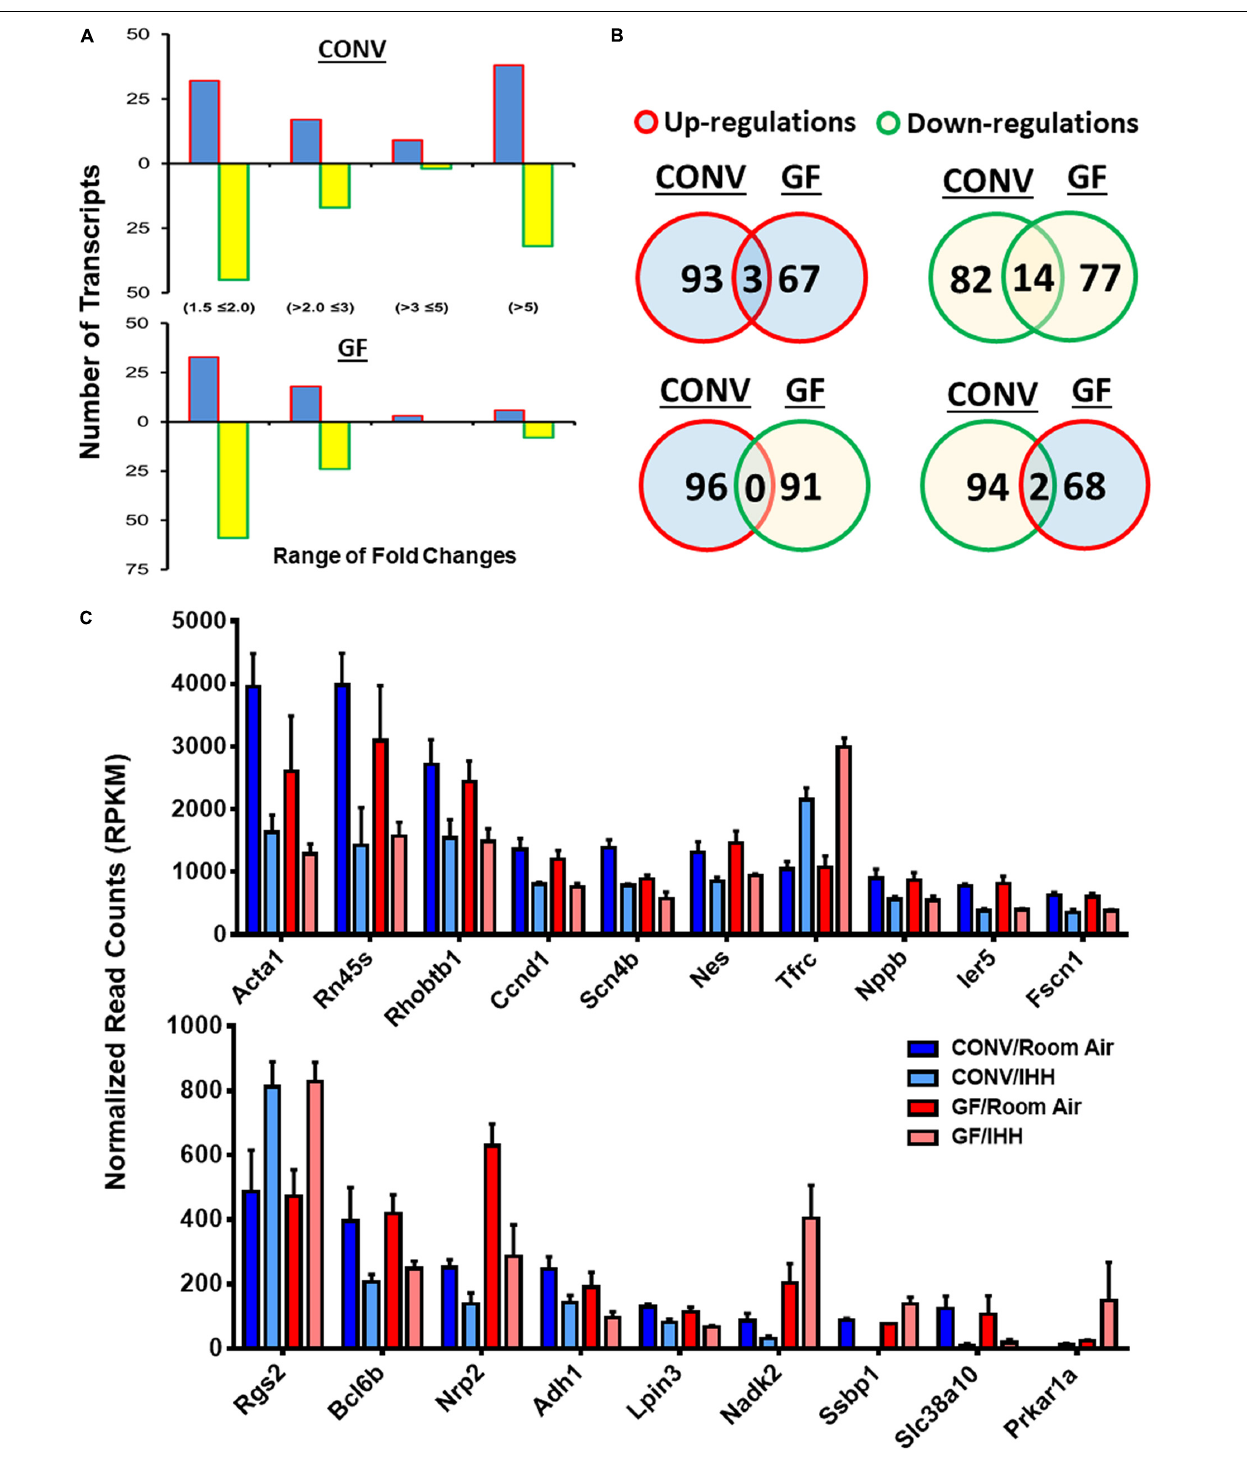
FIGURE 5 | Summary of IHH-induced differentially expressed genes (DEGs) in the hearts of CONV and GF mice. (A) Distribution of DEGs in GF and CONV mice following IHH exposure. Note that a significantly larger proportion of the alterations > 5-fold was detected in the CONV mice as compared to that in the GF mice ( p < 0.05, chi-square test). Blue bar: up-regulations; yellow bar: down-regulations. (B) IHH exposure-induced common transcriptional alteration between GF and CONV mice, where 3 DEGs were upregulated and 14 DEGs were downregulated in both CONV and GF mice. Two other DEGs were downregulated in CONV but upregulated in GF mice. Red circles with blue fill-in: upregulations; green circles with yellow fill-in: downregulations. Overlaps: number of common changes observed in both CONV and GF mice. (C) Transcriptional abundance of the common DEGs in GF and CONV mice in room air or under IHH condition (| Fold change| > 1.5, Benjamini–Hochberg adjusted p <